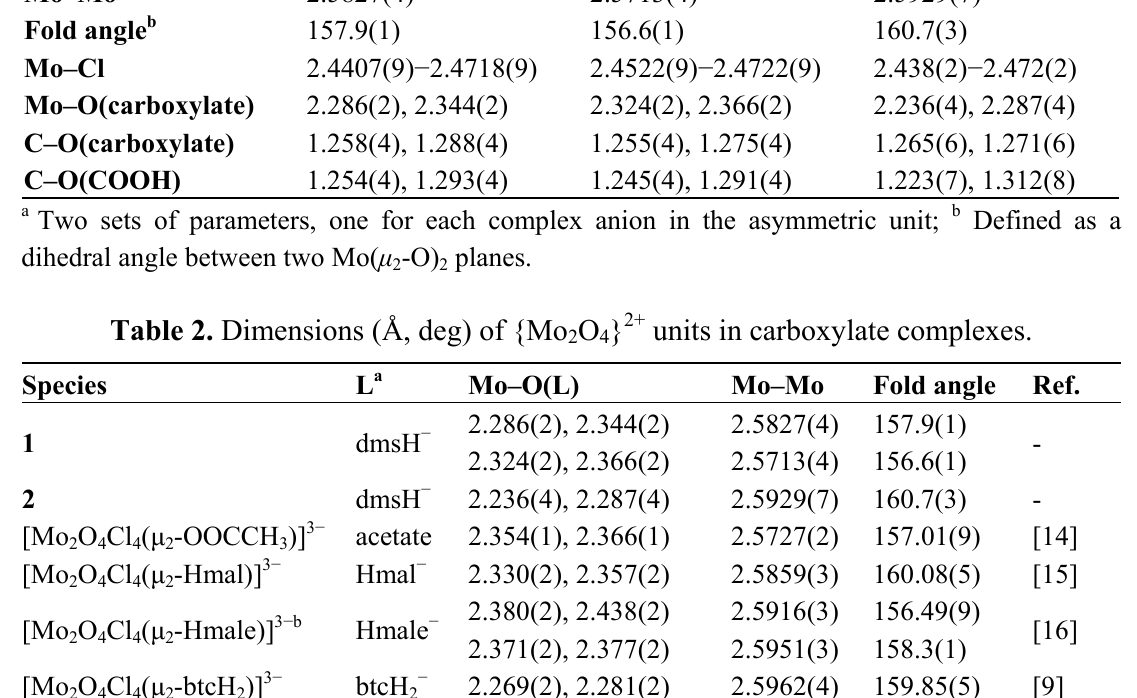
Table 1. Relevant bonding parameters (Å, deg) of [Mo